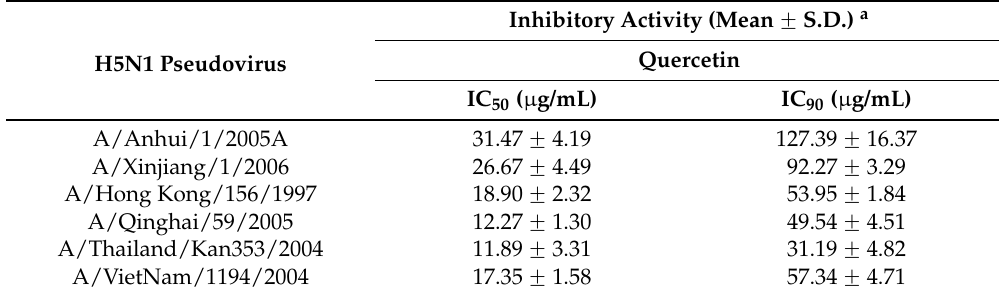
Table 2. Inhibitory activities of quercetin on infection by different H5N1 pseudovirus